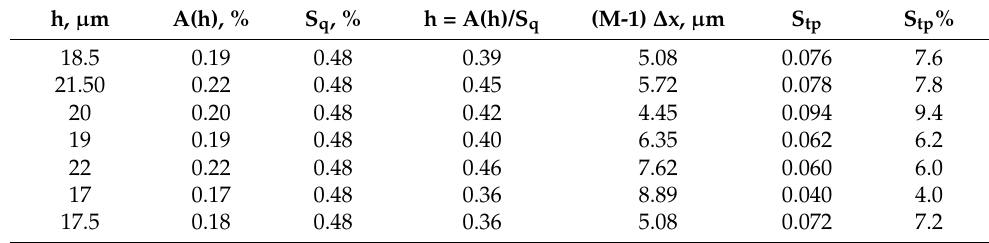
Table 2. The results of calculating the bearing capacity for the AISI 420 steel surface after laser alloying with a plaster of 85Nb + 15% liquid